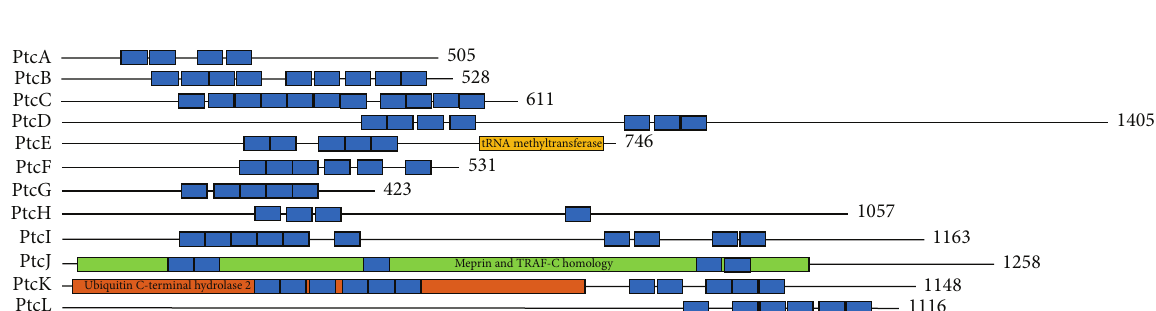
Figure 1: Predicted domain architecture of D. discoideum PPR proteins, PtcA-L. Blue boxes represent PPR motifs. The amino acid length of each protein is indicated at the C-terminus of each protein. Also displayed are the putative tRNA methyltransferase (yellow), MATH-like (green), and ubiquitin hydrolase-like (orange) domains of PtcE, PtcJ, and PtcK,